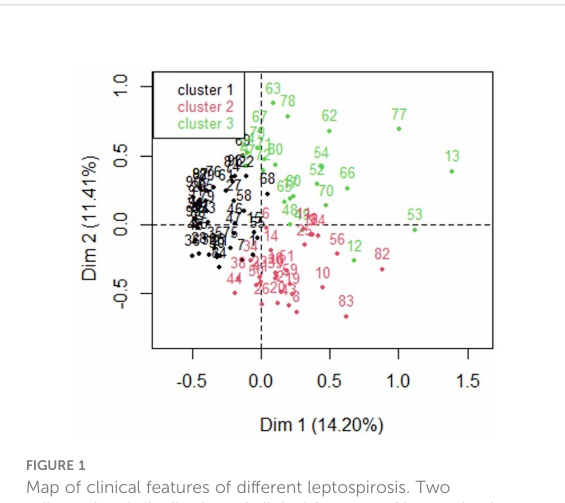
FIGURE 1 Map of clinical features of different leptospirosis. Two − dimensional distribution of clinical features of leptospirosis mapped along the two dimensions (dim 1 and dim 2) identi fi ed by multiple correspondence analysis. The relative positions of the patients in the plane are represented by different colors re fl ecting the subtypes distinguished by cluster analysis. Cluster 1 (black; n = 43) was the mild leptospirosis, cluster 2 (red; n = 28) was the respiratory presentation, cluster 3 (green; n = 25) was a hepato − renal